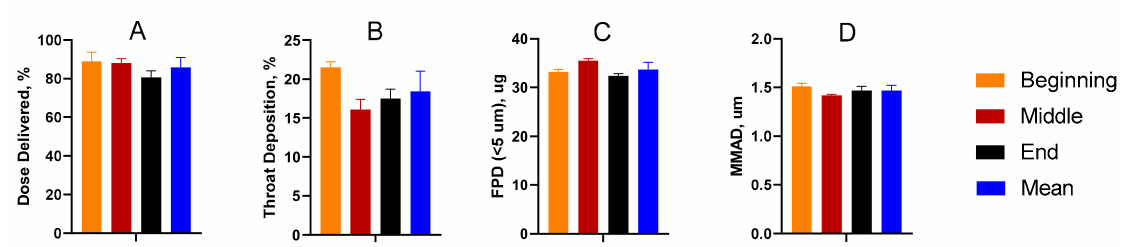
Figure 4. Summary of the delivered dose ( A ), throat deposition ( B ), fine particle dose (FPD) ( C ), and median mass aerodynamic diameter (MMAD) ( D ) throughout the life of the can studies, indicating consistent aerosol performance over time.